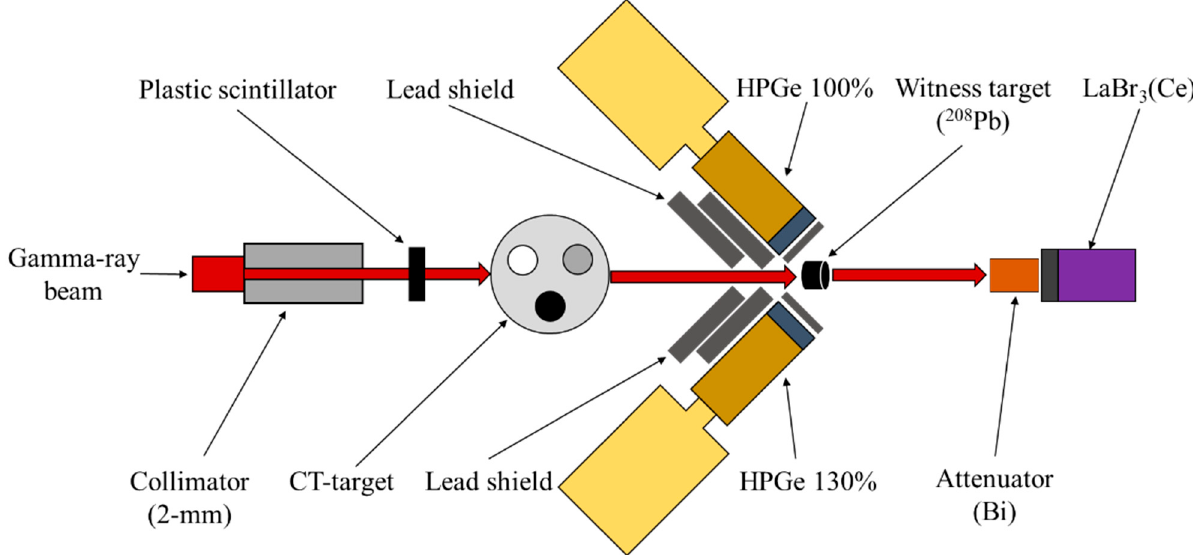
Figure 1. Schematic diagram of the experimental setup at the BL1U beamline in the ultraviolet synchrotron orbital radiation- III (UVSOR-III) synchrotron radiation facility. A lead collimator is positioned at the laser Compton scattering (LCS) gamma ray beam path. A plastic scintillator is used to measure the flux of the incident LCS gamma ray beam. The LCS gamma ray beam path is intercepted by a computed tomography (CT) target, which is positioned on a three-dimensional moving stage. Two high-purity germanium (HPGe) detectors, shielded by lead blocks, are used to measure the nuclear resonance fluorescence (NRF) gamma rays scattered from a witness target ( 208 Pb). To prevent pile-up events, a bismuth absorber is used in front of an LaBr 3 (Ce) scintillation detector, which measures the transmitted gamma